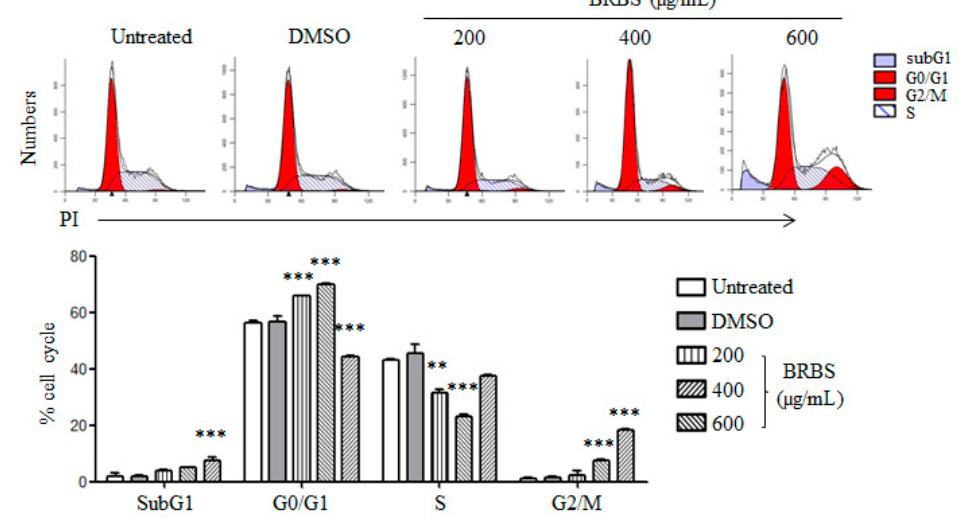
0.001 compared to